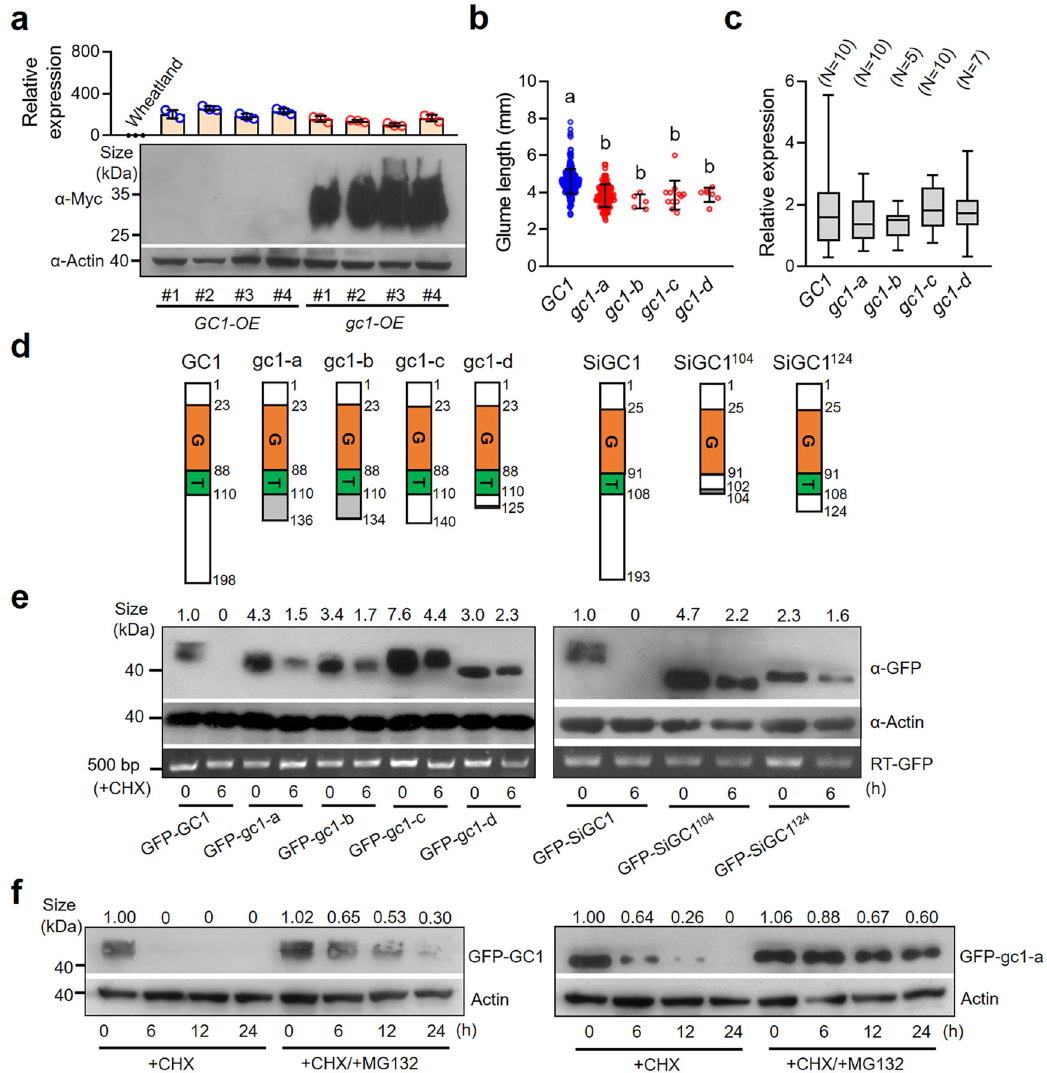
Fig. 3 The C-terminal truncated gc1 confers low glume coverage by accumulating higher protein level. a Immunoblot analysis of Myc tag fused GC1 and gc1 proteins extracted from the young panicles of transgenic GC1-OE and gc1-OE sorghum plants, respectively. The relative expression of GC1 and gc1 in transgenic plants compared to Wheatland were detected by qPCR. b Glume length evaluation of fi ve GC1 haplotypes among 482 sorghum accessions. Data are mean ± s.e.m. c Comparison of GC1 expression level among the fi ve GC1 haplotypes. The two ends of the box plot and the upper, middle, and lower box lines represent the upper edge, lower edge, median and two quartiles of values in each group. Statistical signi fi cance was determined by one-way ANOVA with Tukey ’ s multiple comparisons test in b and c . d Schematic diagram of peptide structure of natural or synthetic GC1, gc1-a, gc1-b, gc1-c, gc1-d, SiGC1, SiGC1 104 , and SiGC1 124 proteins. G, G protein γ subunit domain. T, Predicted transmembrane domain. The gray color shows the out-frame amino acids. e GFP tag fused with various deletion-based GC1 and SiGC1 proteins showed in d were transiently expressed in N. benthamiana leaves. Protein levels were subsequently analyzed by western blotting with anti-GFP antibody after 30 μ M CHX treatment for 0 and 6 h. The expression of GFP tag from tobacco leaves were detected by RT-PCR. f The protein accumulation of GFP-GC1 and GFP-gc1-a extracted from tobacco leaves after treatments with CHX (30 μ M) or CHX (30 μ M) + MG132 (50 μ M) for 0, 6, 12, and 24 h were analyzed by western blotting with anti-GFP antibody. Plant actin was used as the loading control. CHX cycloheximide. The numbers on the blot bands indicate the relative protein quanti fi cation by determination of grayscale value. Three independent experiments were performed in e and f . Source data are provided as a Source Data fi